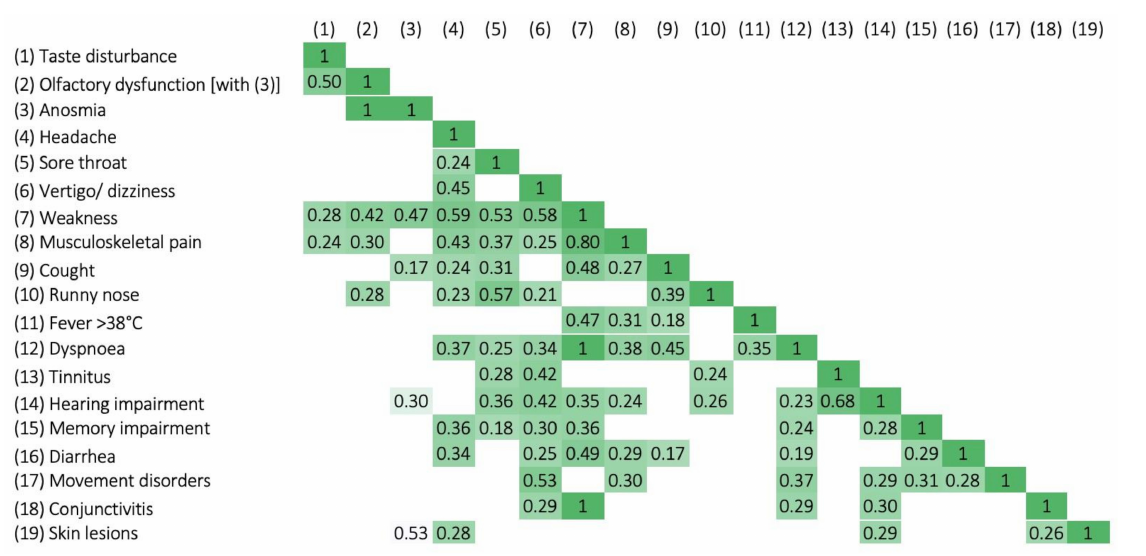
Figure 4. Correlation coefficient (r) of ENT and systemic symptoms in the course of COVID-19 at the significance level of p <